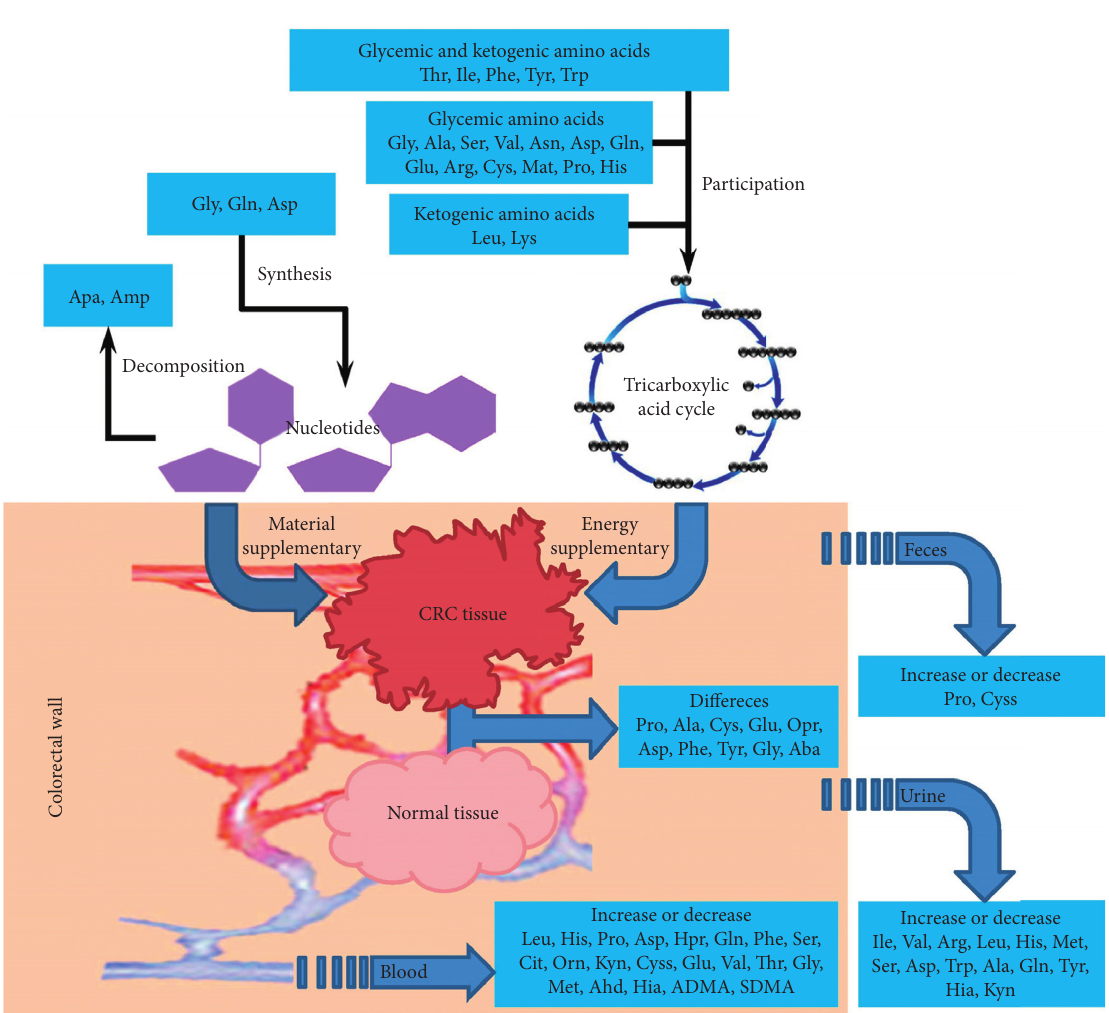
Figure 1: The association of amino acids with the formation, growth, and metabolism of